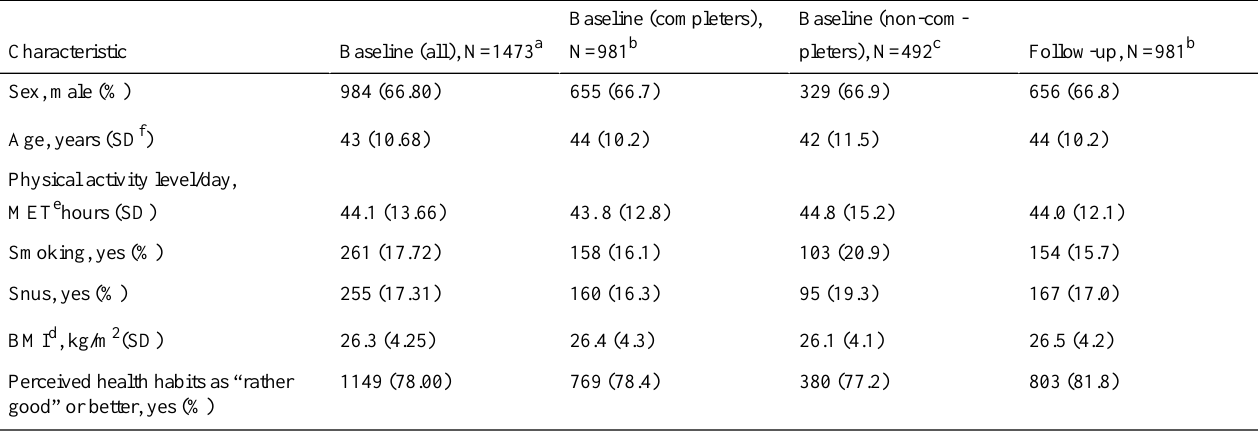
Table 1. The participants’basic characteristics at baseline (all sample, completers, and noncompleters) and